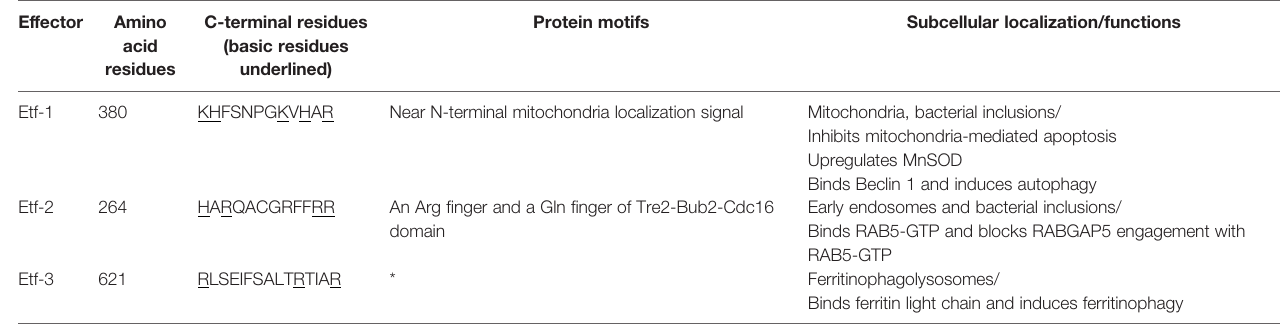
TABLE 1 | Characteristics of Type IV secretion effectors from E. chaffeensis